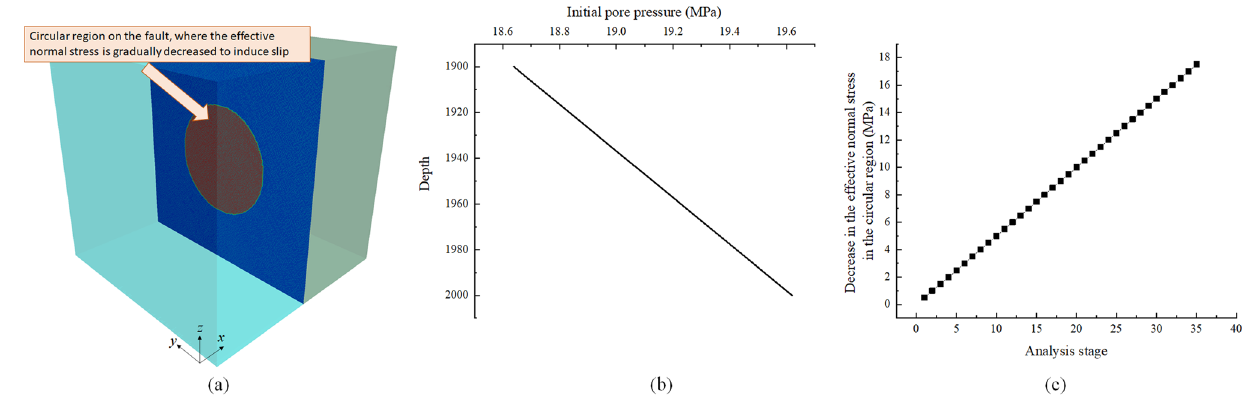
Fig. 6 Effective normal stress reduction to induced slip on the fault plane: a Circular region on the fault, where the effective normal stress is decreased b Initial pore pressure distribution on the fault c Effective normal stress reduction in each analysis